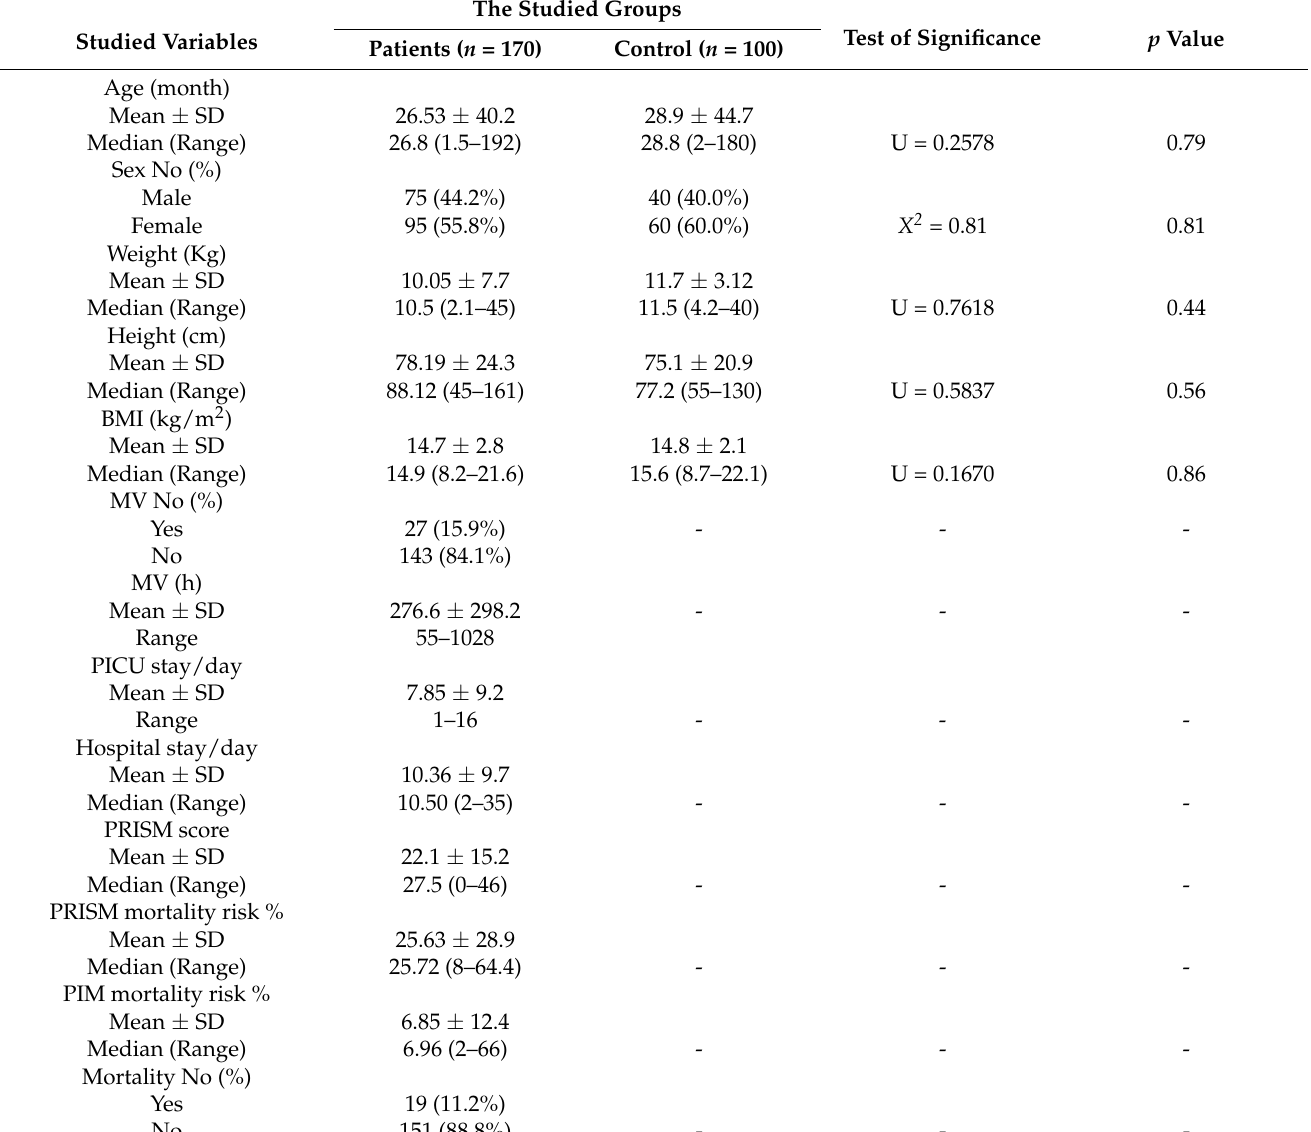
Table 1. Demographic and clinical characteristics of the studied